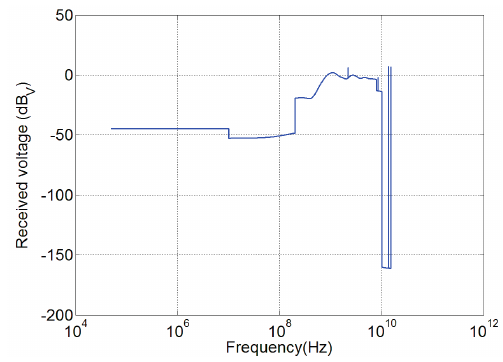
Figure 11. Susceptibility voltage level for the Vivaldi